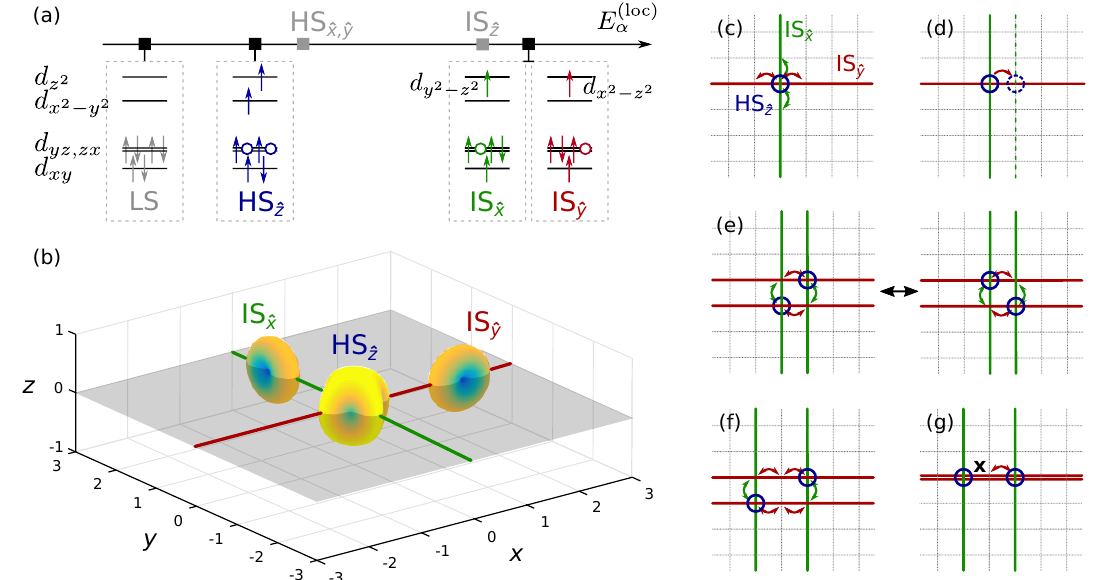
Figure 2: (a) Spin configurations of the relevant atomic d 6 states with tentative po- sitions of their local energies E ( loc ) in the strained LaCoO . (b) Isosurfaces of the α 3 electron charge density from active (singly-occupied) orbitals of excitons in the lat- tice. (c)-(g) Schematic representation of spatial configurations studied within the ED approach in the x y plane. The mobile IS excitations are represented by lines and HS bi-excitons by open circles at their